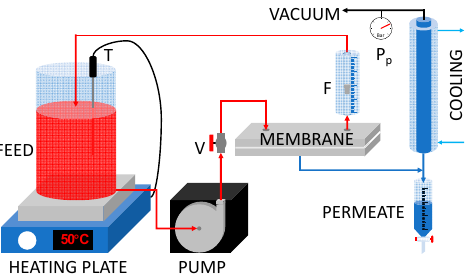
Figure 2. VMD setup scheme. V: valve for the flow regulation; F: flow meter; P: vacuum meter; T: temperature control probe.